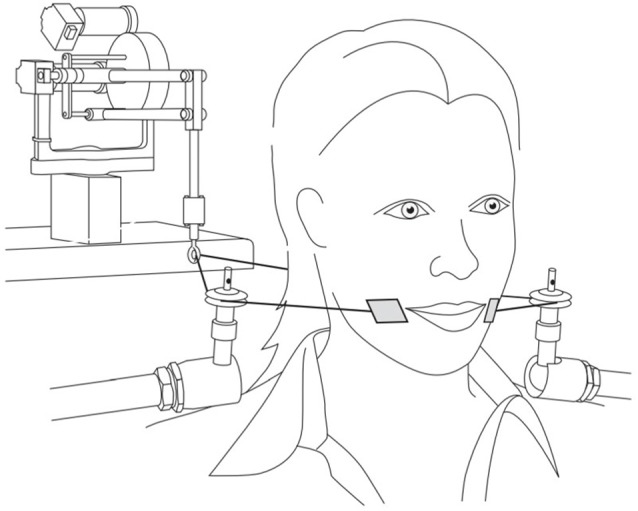
Experimental set up for facial skin stretch perturbations (reproduced with permission from Ito and Ostry, 2010).